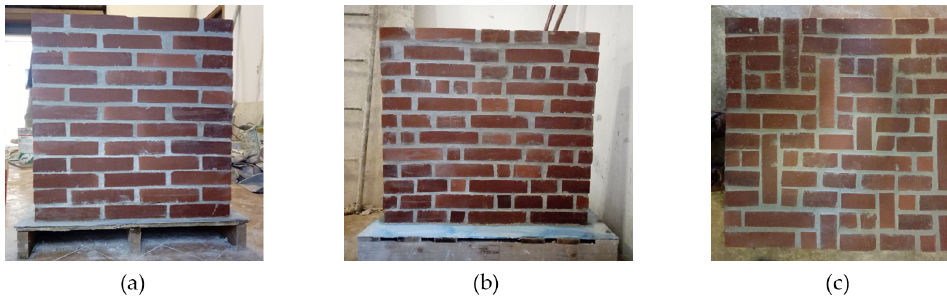
Figure 6. ( a ) periodic, ( b ) quasi-periodic and ( c )